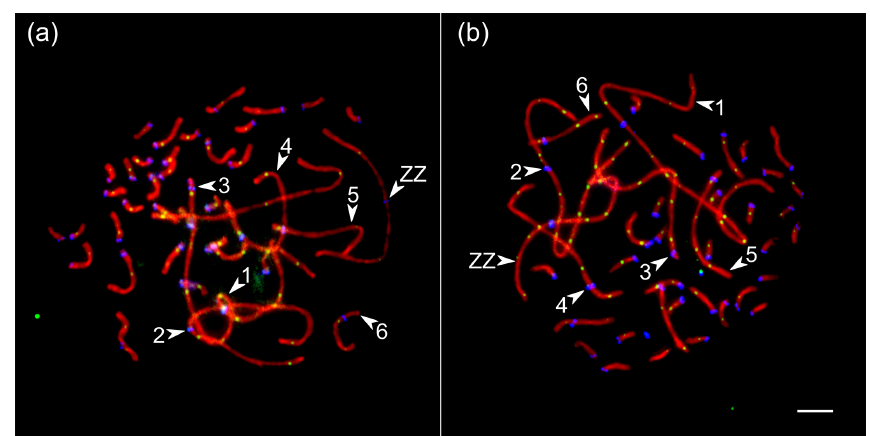
Figure 1. Synaptonemal complexes (SCs) of Russian Crested (a) and Russian White (b) roosters after immunolocalization of SYCP3 (red), centromeres (blue) and MLH1 (green). Arrowheads point to the SCs of the macrochromosomes identified by their lengths and centromere indices. Bar: